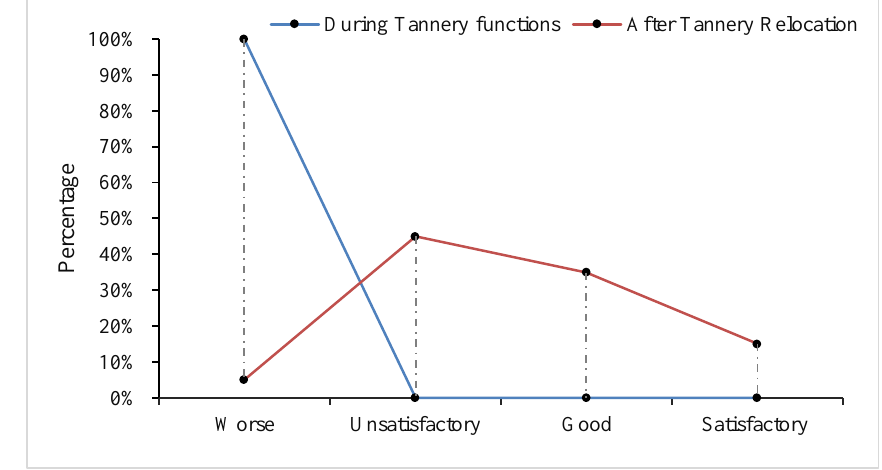
Figure 3: Change in Outdoor Environment and Drainage in